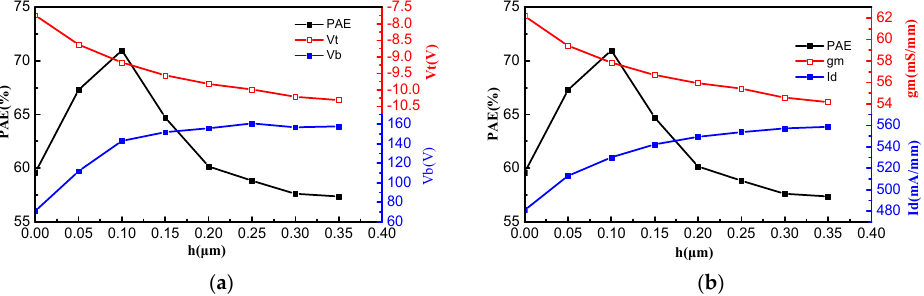
Figure 4. ( a ) The effect of the ultrahigh upper gate height h on PAE, V t and V b ; ( b ) The effect of the ultrahigh upper gate height h on PAE, V t and V b .